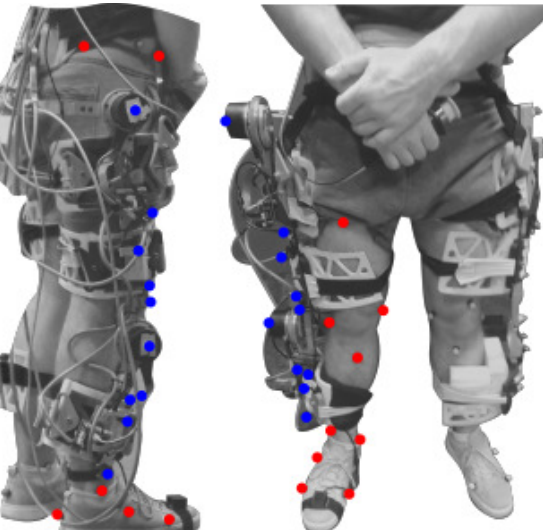
Figure 5. Markers setup used in the pilot study. Highlighted in red are the user’s markers and the exoskeleton’s markers in